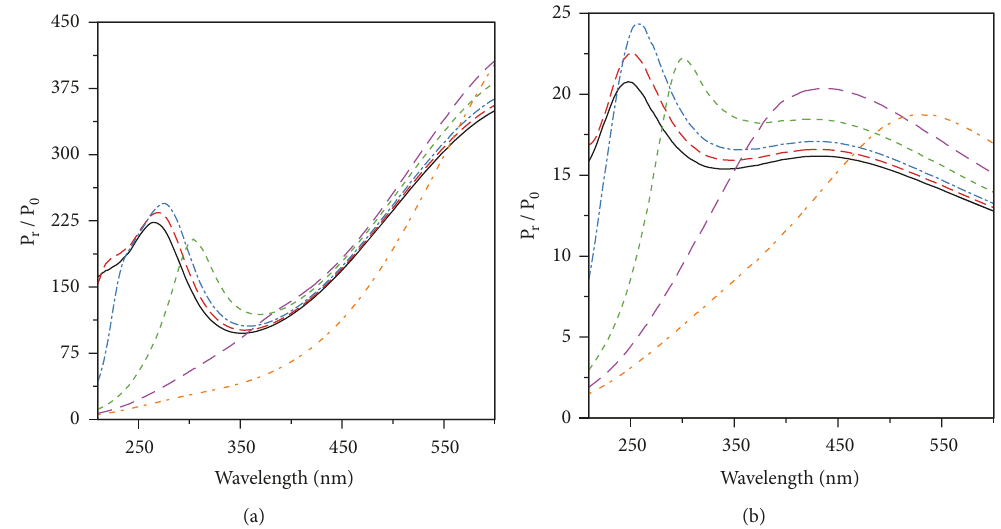
Figure 3: Normalised power radiated by spherical particles 5 nm above a substrate, illuminated by an electric dipole. For substrates comprised of (a) Al and (b) SiO 2 . All curves correspond to the same volume fractions indicated in Figure